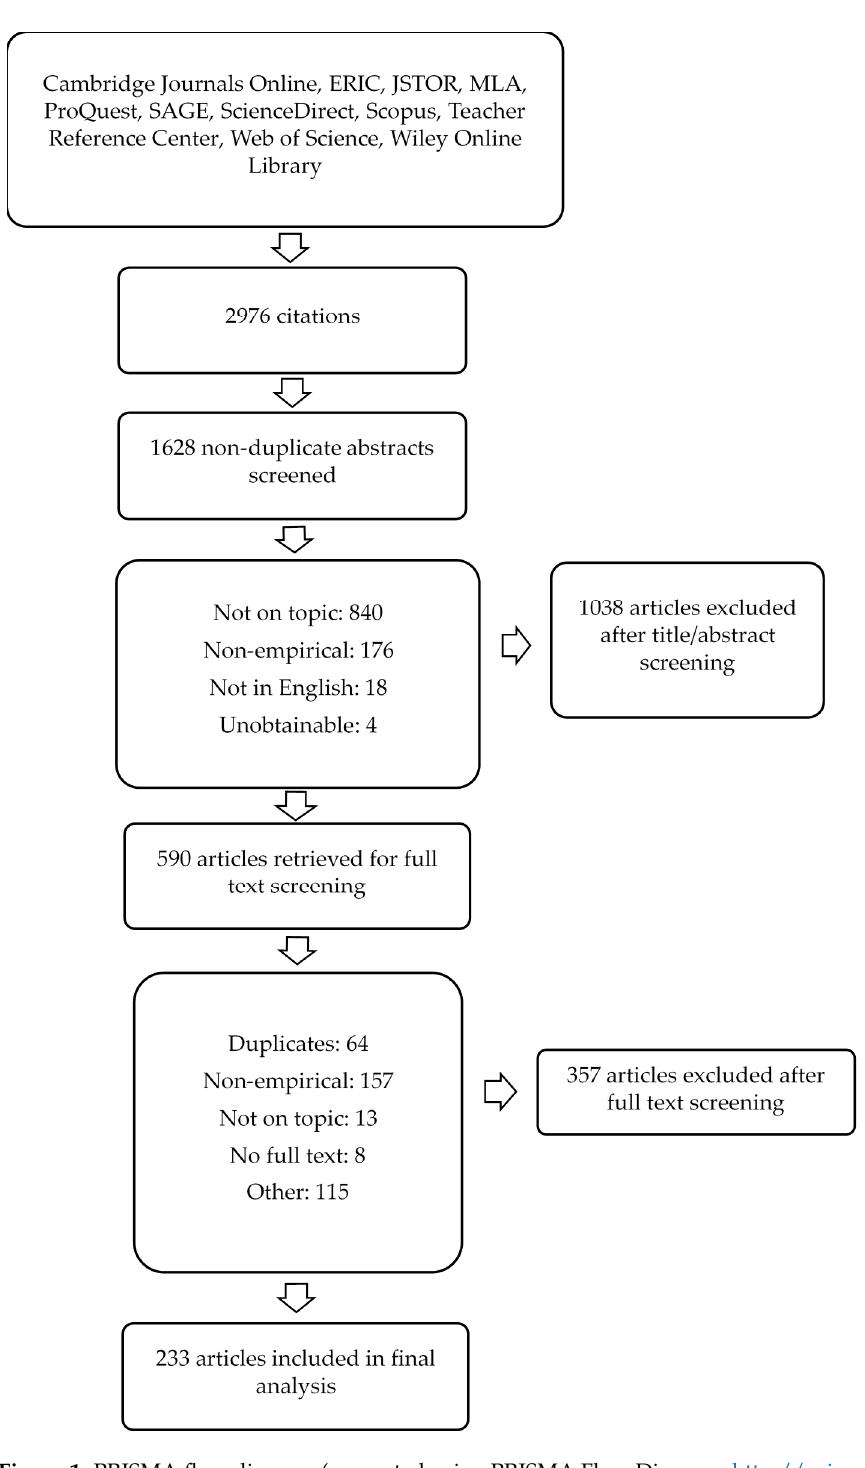
Figure 1. PRISMA flow diagram (generated using PRISMA Flow Diagram, http://prisma-statement.org/PRISMAState- ment/FlowDiagram, accessed on 25 March 2021).